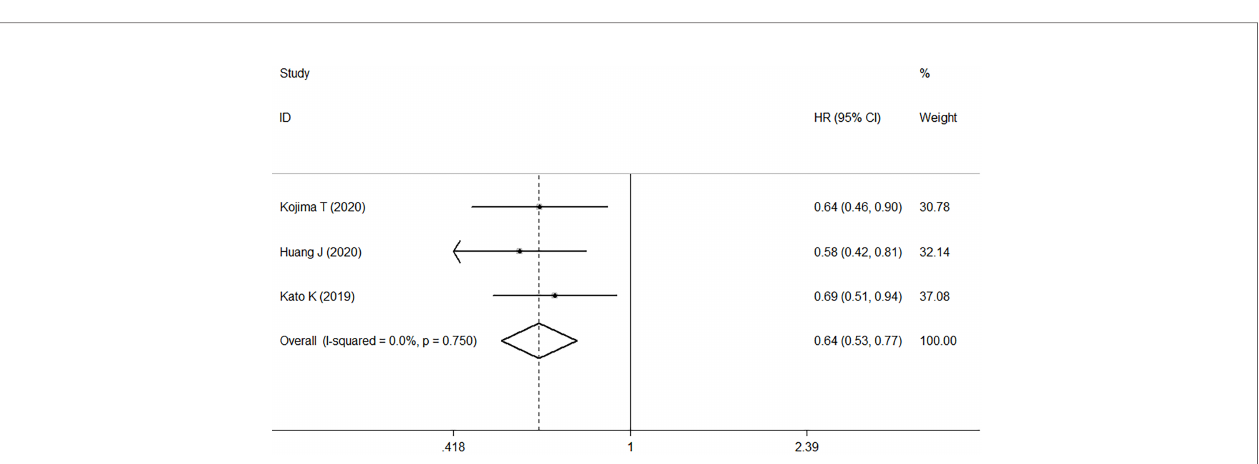
Frontiers in Oncology |